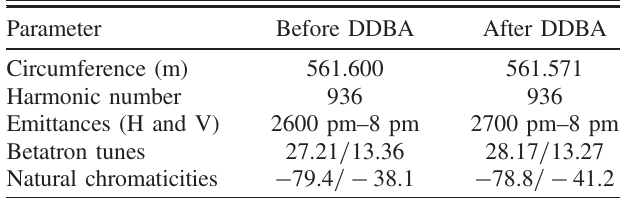
TABLE. I. Comparison of main lattice parameters before and after the DDBA cell